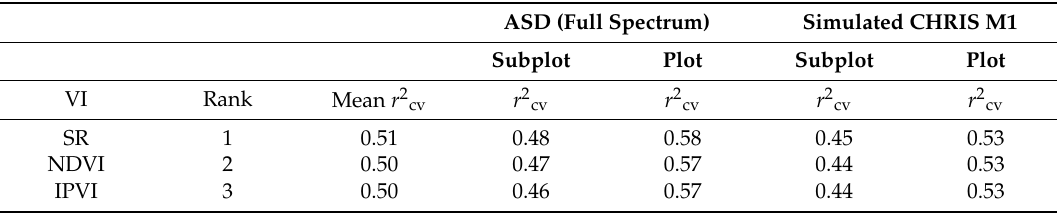
Table 3. Two-band VIs ranked. Overall ranking of the top three VIs based on mean r 2 cv and incorporates tests from all variables (e.g., LCC, PAI, and CCC), angles, scales, and spectral modes.